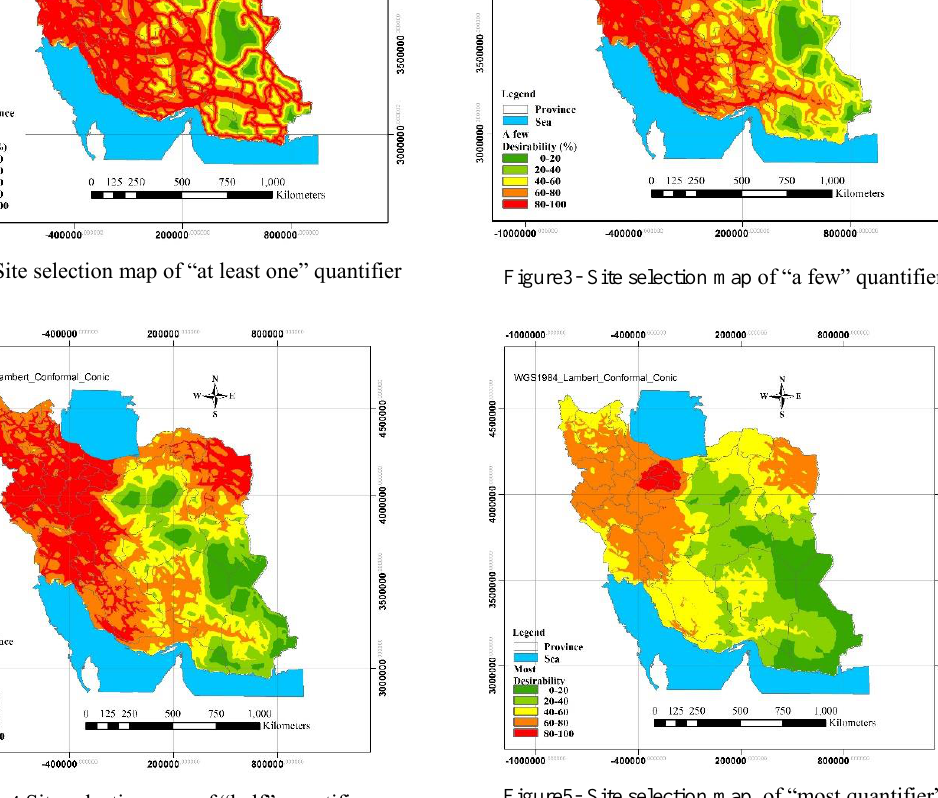
Figure 4 Site selection map of “half” quantifier Figure5- Site selection map of “most quantifier”